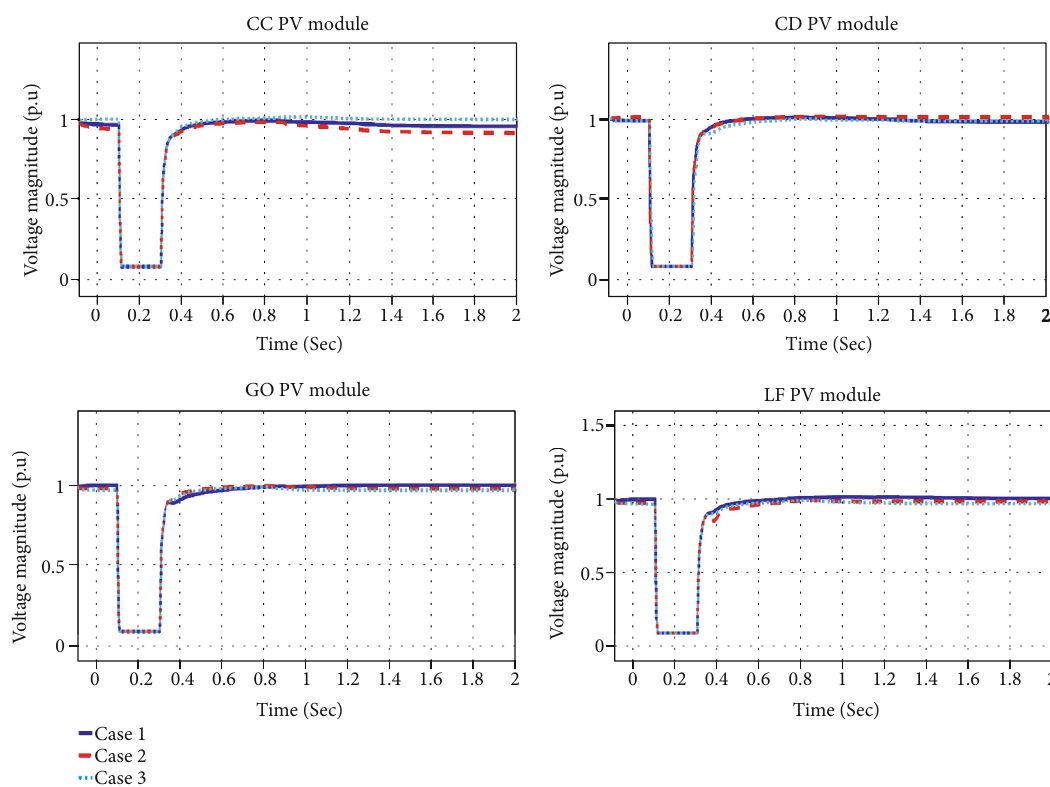
Figure 17: Voltage magnitudes from PV module for four dispatch strategies. This fi gure is reproduced from Shezan et al.